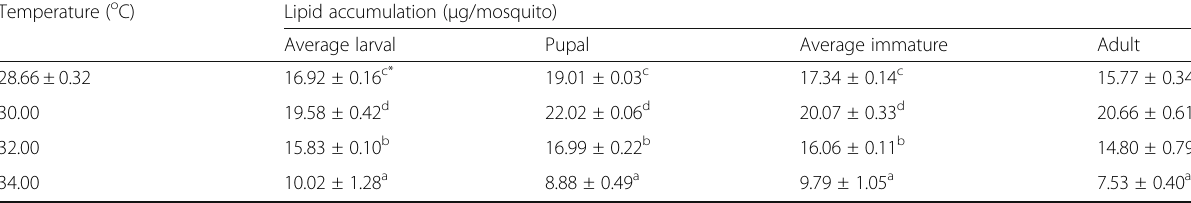
*Within a column, means (±SD) followed by same letter are not significantly different at p <0.05 according to Duncan multiple range test following analysis of variance